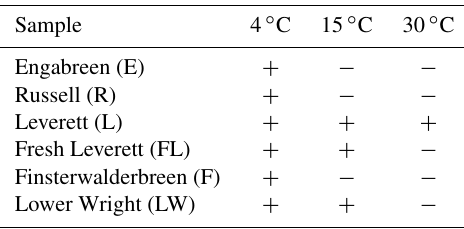
Table 1. Occurrence of microbial iron reduction in enrichment cul- tures. Positive ( + ) and negative ( − ) indications refer to second- generation duplicated (from single initial) 4 and 15 ◦ C, and ini- tial 30 ◦ C enrichment cultures. Initial enrichments were inoculated with thawed subglacial sediment in anoxic bicarbonate-buffered medium amended with ∼ 100mM poorly crystalline ferric iron ox- ide and 10mM each of lactate and acetate. Second-generation en- richments were established using a 10% v/v inoculum from initial enrichments. Microbial iron reduction was monitored by measuring the production of HCl-extractable Fe(II) over time using the fer- rozine assay (Stookey, 1970). Enrichments were considered positive where an increase in Fe 2 + concentration ≥ 5mM (compared with blanks) was measured within 50 days of initiating the enrichment. This concentration was chosen as a nominal figure that significantly exceeded the typical error of the ferrozine assay, as measured in calibration procedures where triplicate ferrozine measurements are conducted on each of five calibration standards ranging from 1 to 50mM.